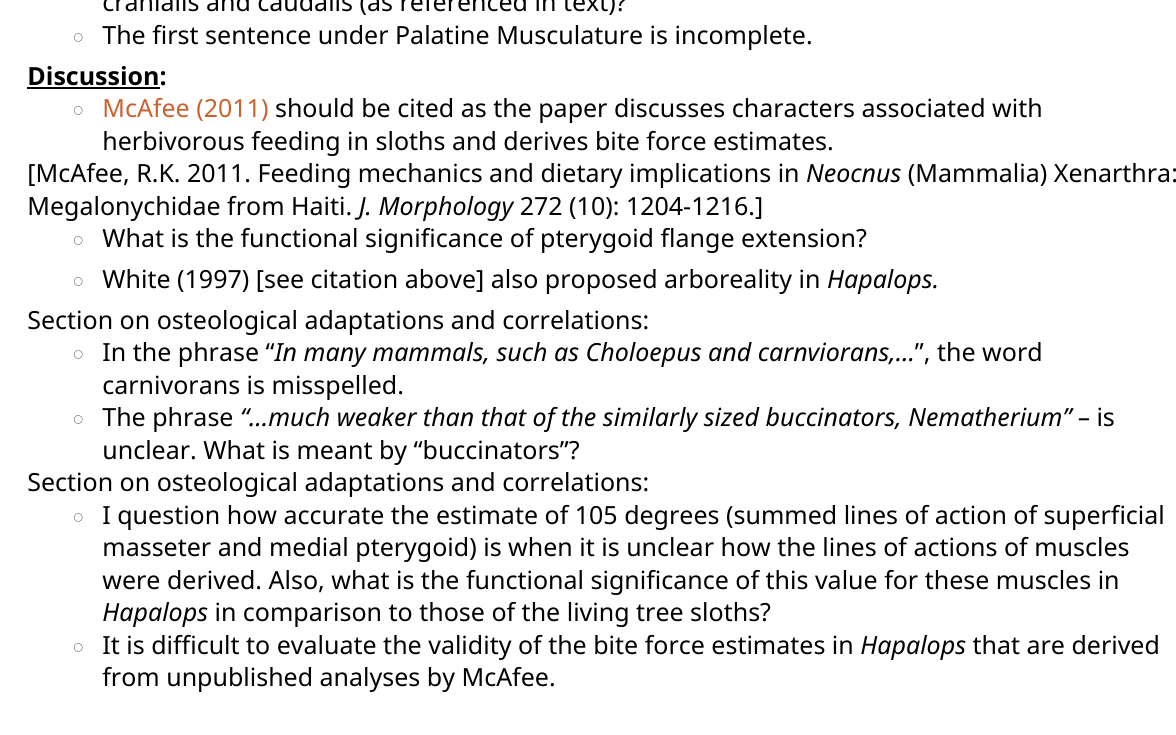
Figure 5: Where is the distinction between M. rectus capitis posterior major et minor? Is this muscle called M. rectus capitis dorsalis in the text, but posterior in the figure? Figure 5: Does M. obliquus superioris (as labeled in the figure) represent M. obliquus capitis cranialis and caudalis (as referenced in